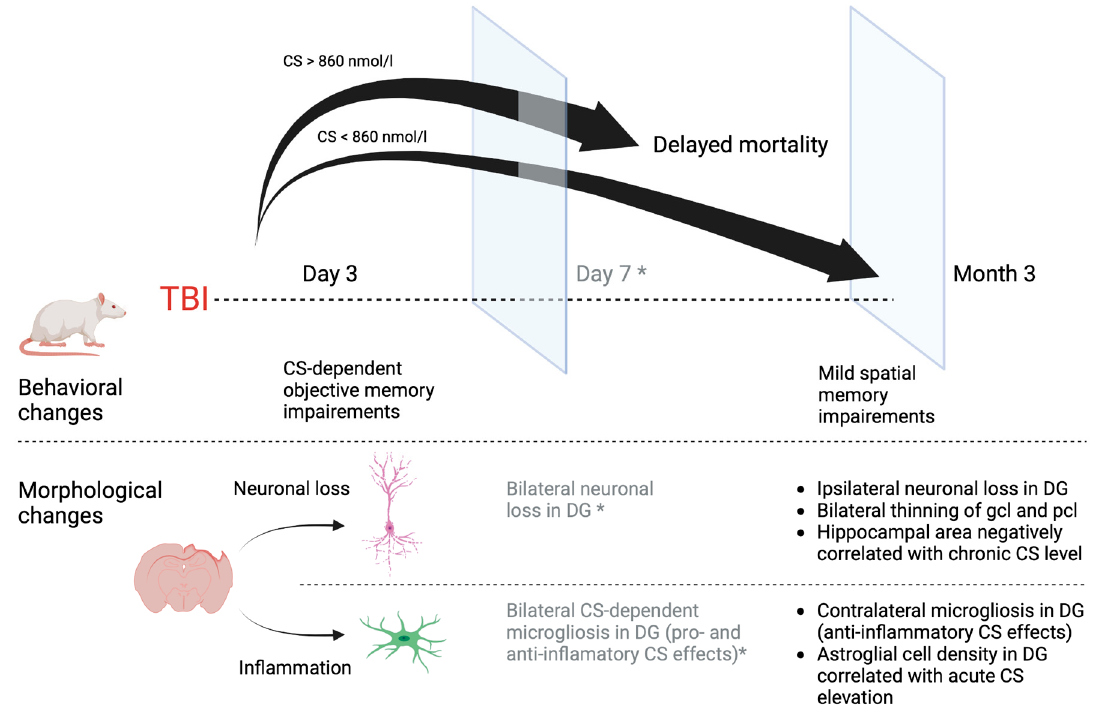
Figure 6. Behavioral and morphological changes in early and late posttraumatic periods. Neuronal cell loss only in the ipsilateral hippocampus accompanied by mild behavioral deficits was revealed in rats 3 months after TBI. In contrast to the early posttraumatic period, these results may be associated with CS-dependent survivorship bias. *—according to our previously published data [15,16], CS—corticosterone, DG—dentate gyrus, gcl—granular cells layer, pcl—pyramidal cells layer.